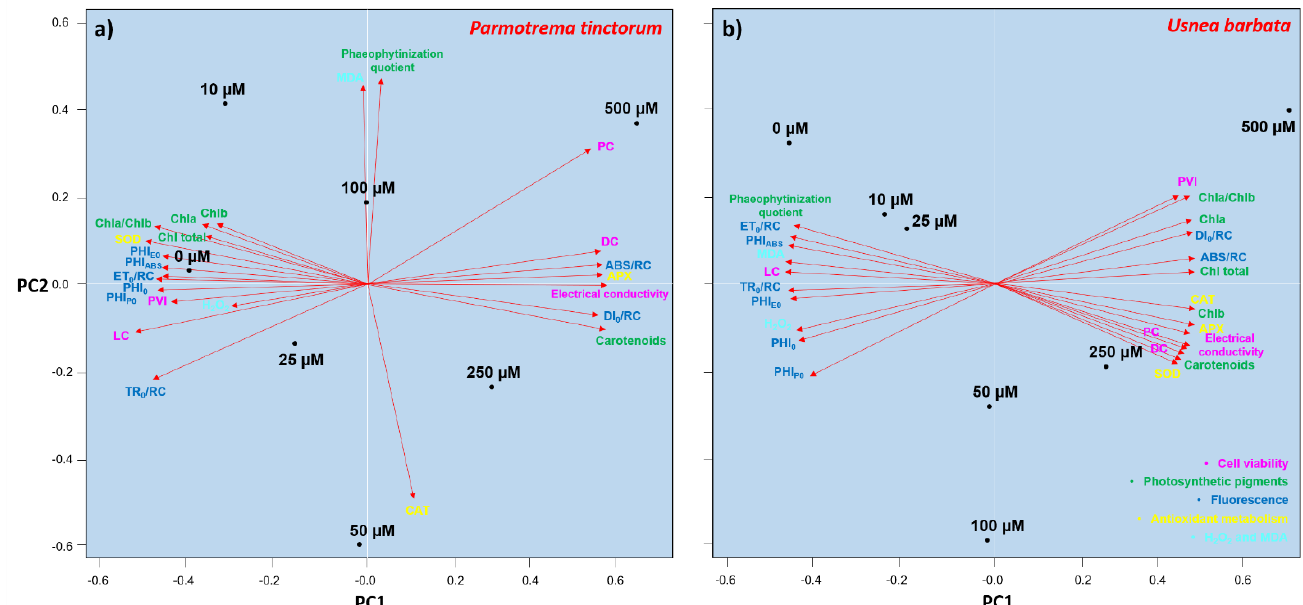
Figure 13. Principal component analysis of the cell viability, photobiont vitality index (PVI), photosynthetic pigment concentrations, electrical conductivity, chlorophyll a fluorescence, antioxidant metabolism enzyme activity, peroxide (H 2 O 2 ), and malondialdehyde (MDA) in the thalli of the lichens Parmotrema tinctorum ( a ) and Usnea barbata ( b ), analyzed as a function of different concentrations of Cd (0, 10, 25, 50, 100, 250, and 500 µM). LC = living cells, PC = plasmolyzed cells, DC = dead cells, ABS/RC = the specific light absorption flux per reaction center, TR0/RC = the energy flux captured per reaction center at t = 0, ET0/RC = the electron transport flux per reaction center, DI0/RC = the specific energy dissipation flux at the level of the chlorophylls of the antenna complex, PiAbs = the photosynthetic performance index, PHIP0 = maximum quantum yield of primary photochemistry, PHI0 = probability that an exciton moves an electron down the electron transport chain after the quinone, PHIE0 = quantum yield of electron transport, Chla = chlorophyll a , Chlb = chlorophyll b , Chl total = total chlorophyll, CAT = catalase, APX = ascorbate peroxidase, and SOD = superoxide dismutase.